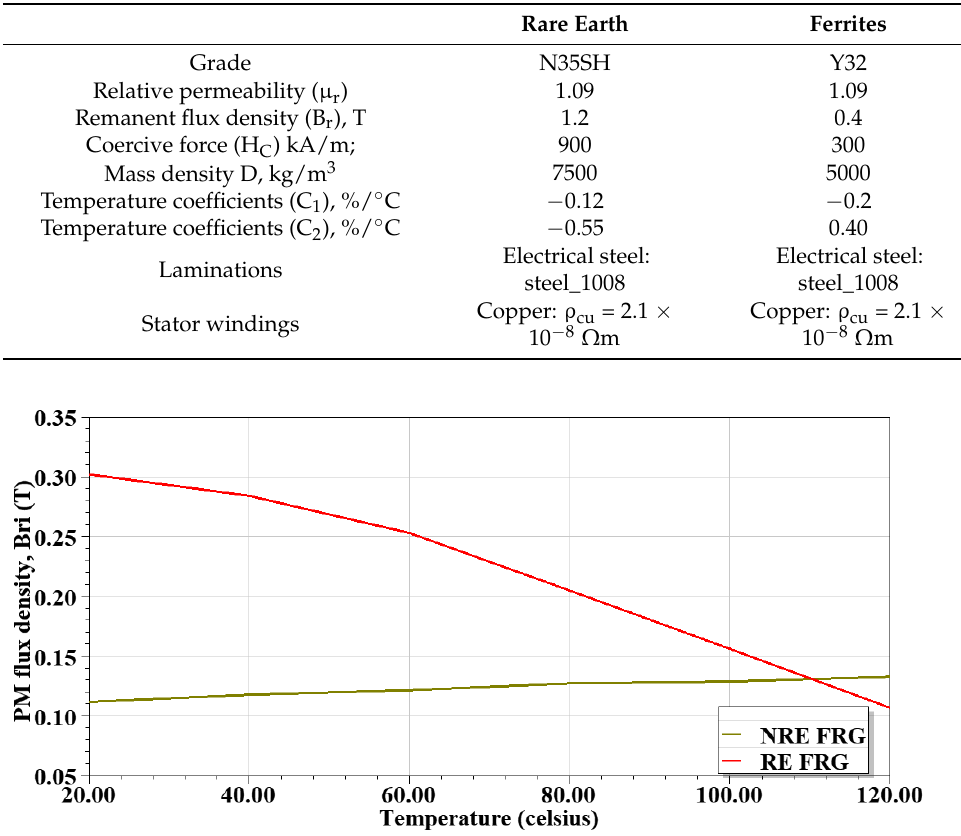
Figure 12. Average PM flux density under various temperatures.